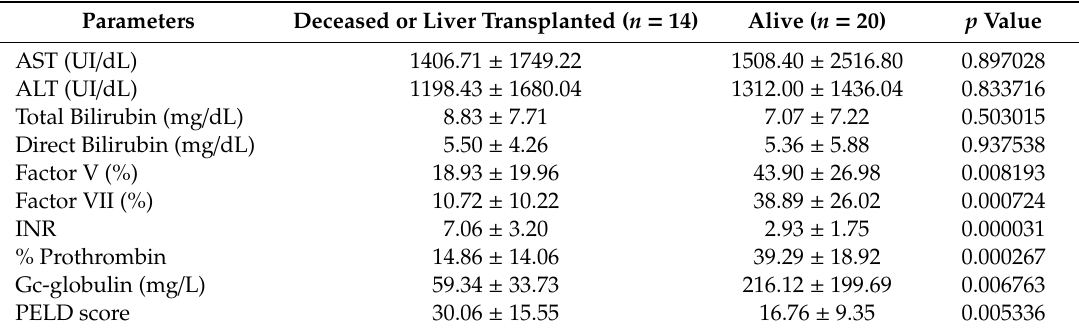
Table 2. Comparison of di ff erent parameters depending on the outcome of acute liver failure.